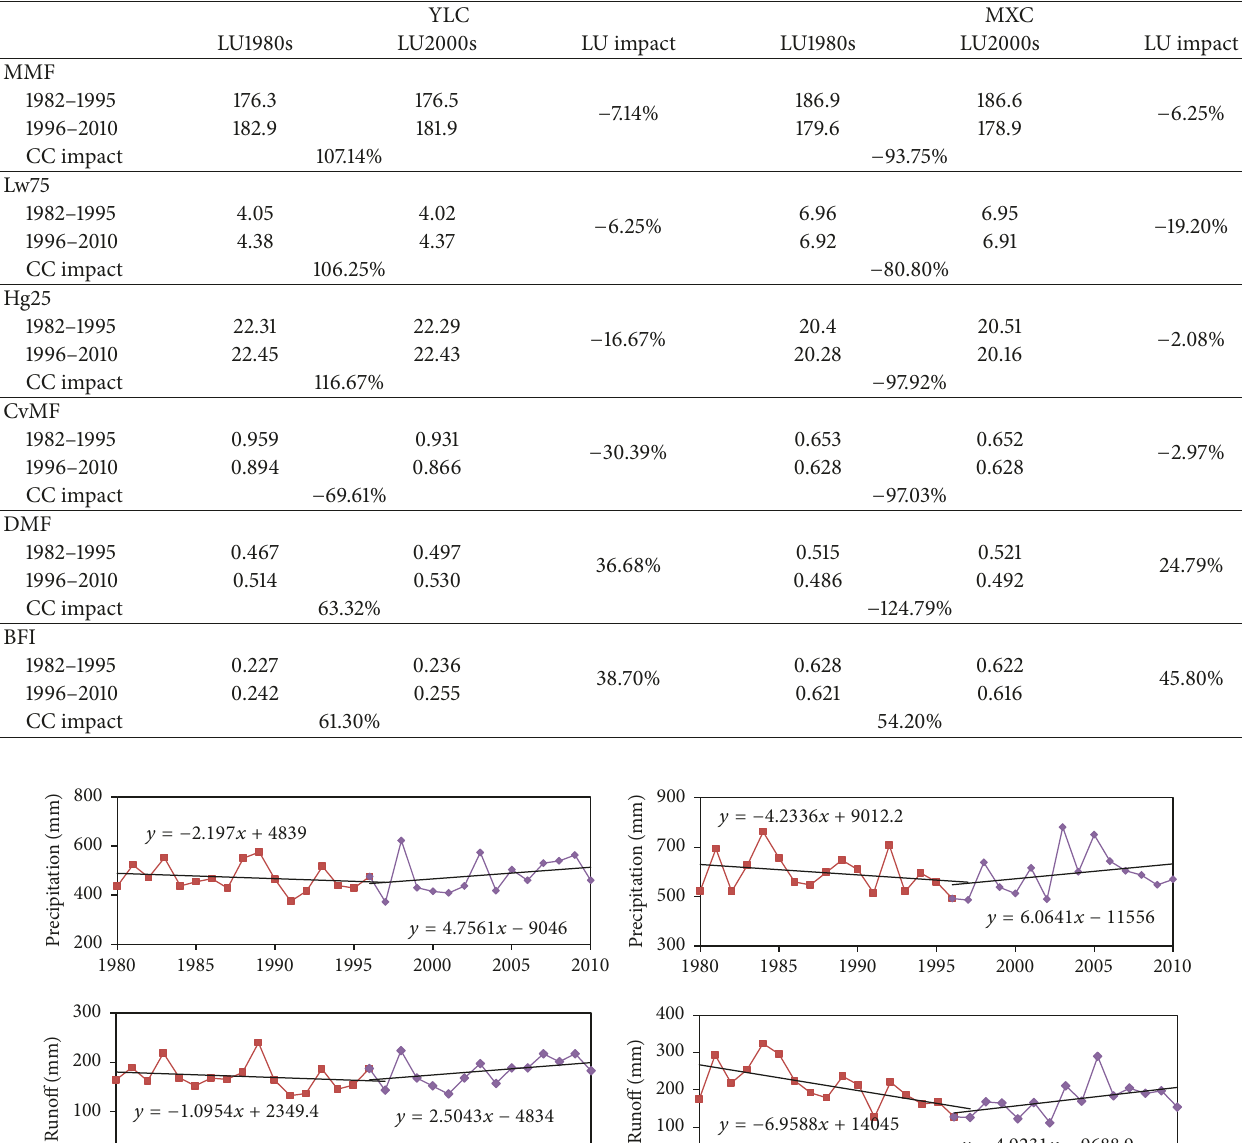
Table 4: Separate contribution of climate change and LUCC on runoff regimes in YLC and MXC.